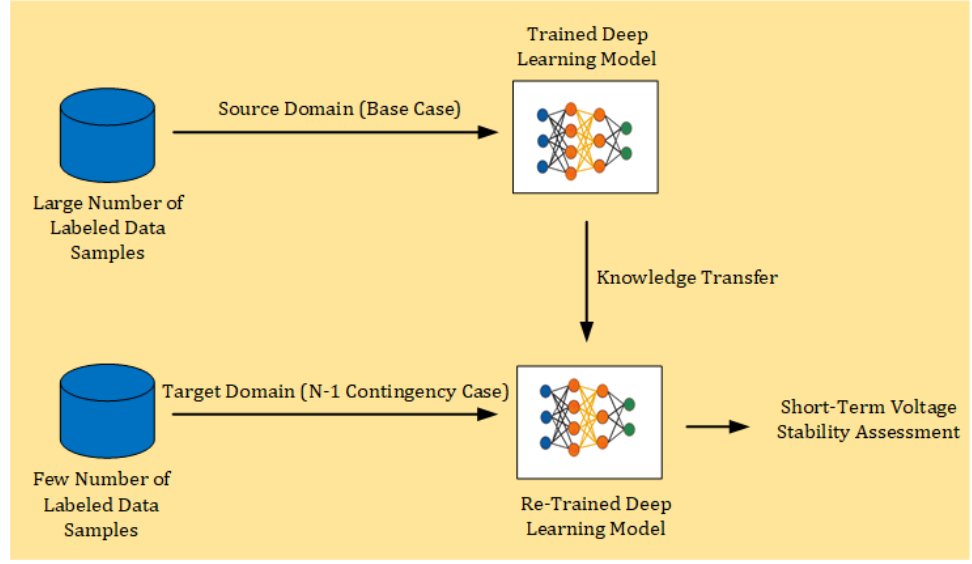
Figure 8. Transfer learning process.